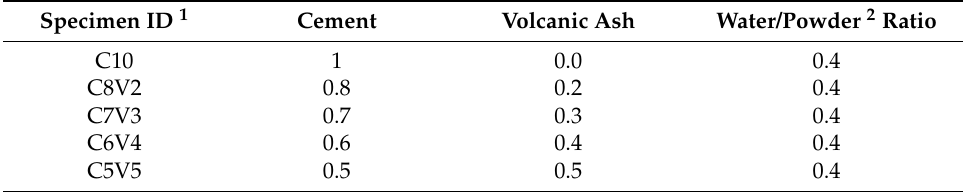
Table 3. Mixture proportion of samples expressed as mass ratio.